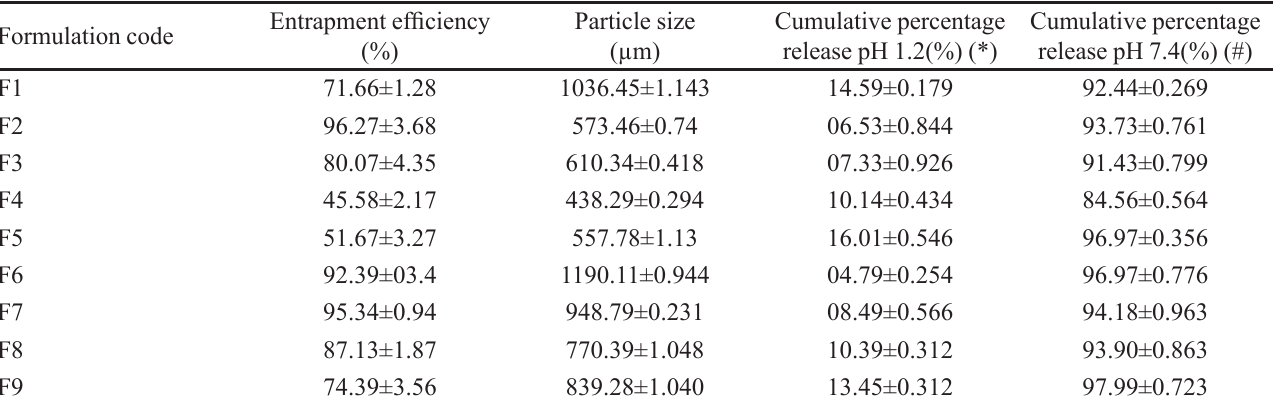
TABLE II - Properties and in-vitro drug release of polymeric alginate beads Formulation